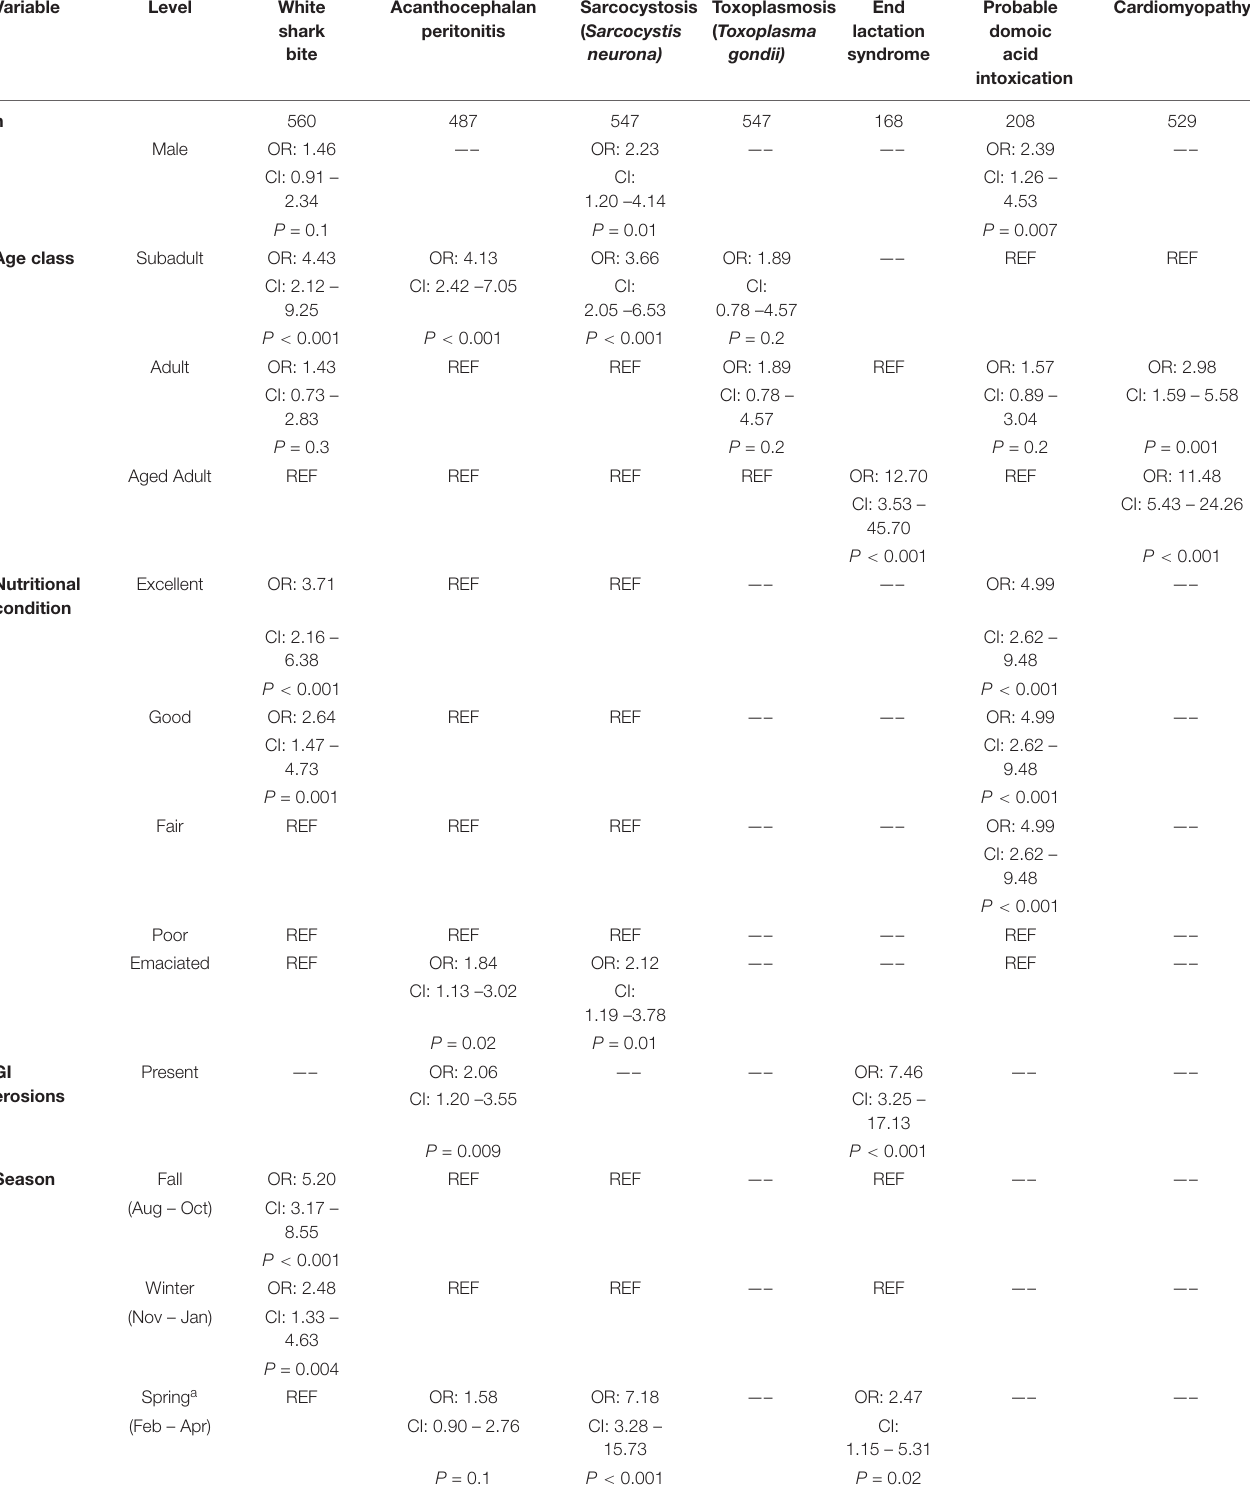
TABLE 4 | Shared measures of effect (odds ratios) for seven common causes of southern sea otter ( Enhydra lutris nereis ) death 1998 – 2012.